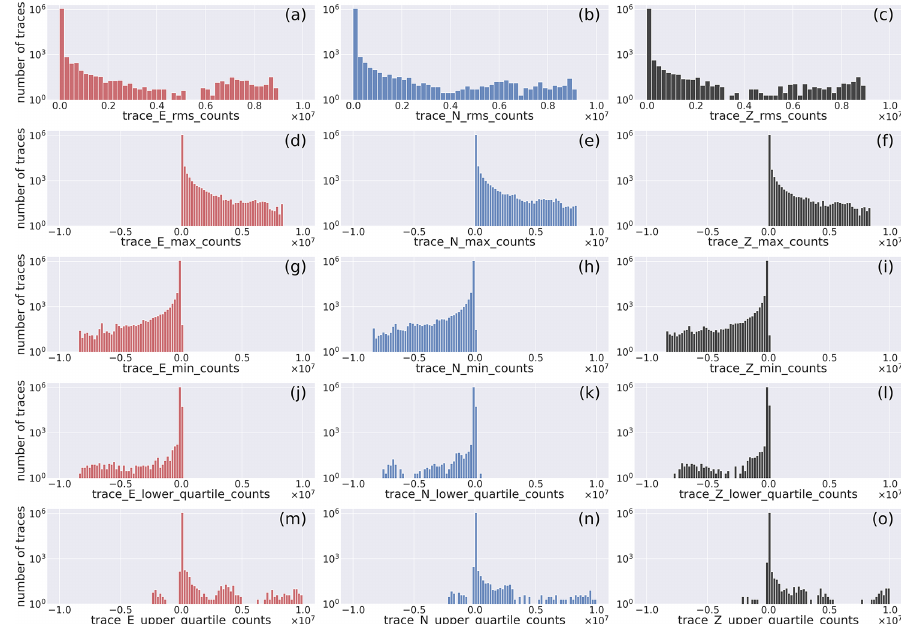
Figure D3. Histogram of the distribution of quality control metadata of the full earthquake dataset, with the horizontal axis inclusive of the complete range of values: rms, min, max, and first and third quartile. The width of the bins is 2 × 10 5 ; axes are labeled according to the metadata listed in Table 2.